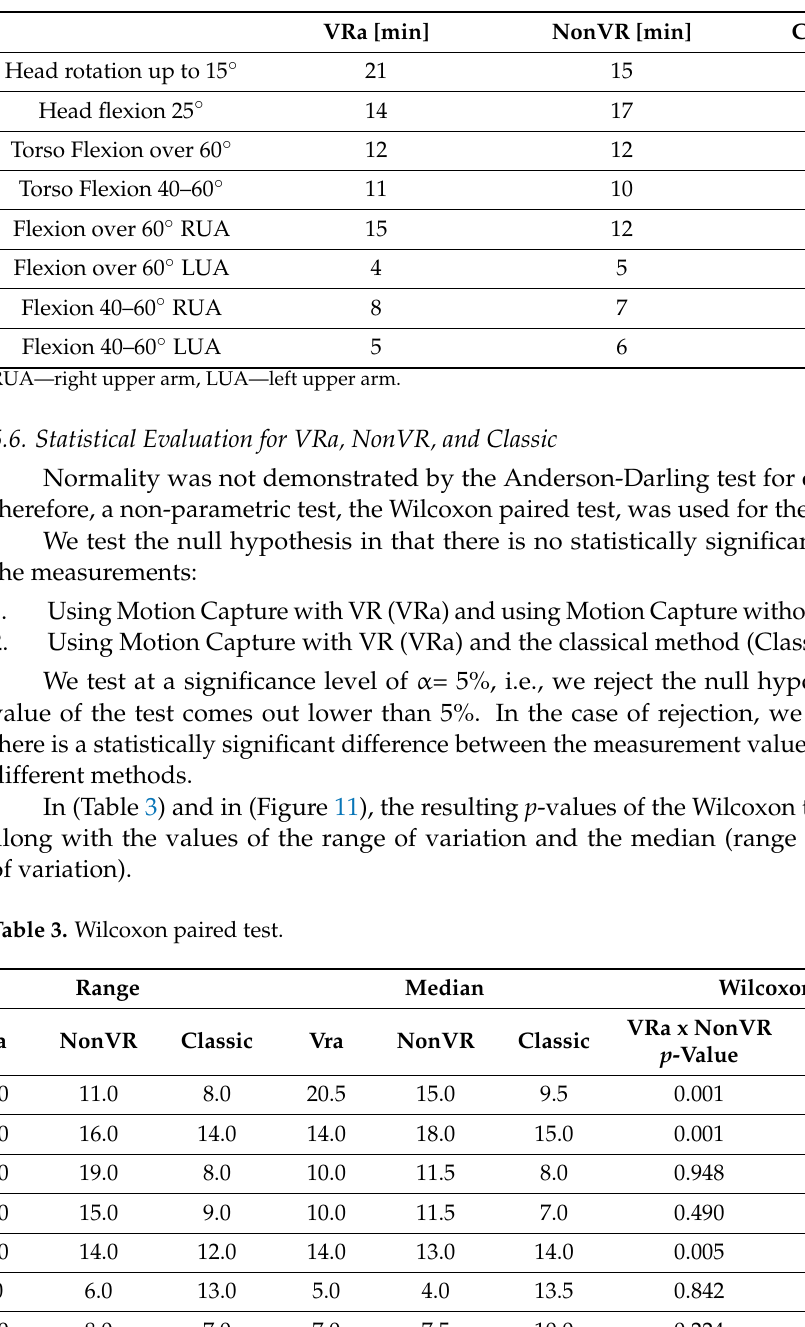
Table 2. Time spent in working position.